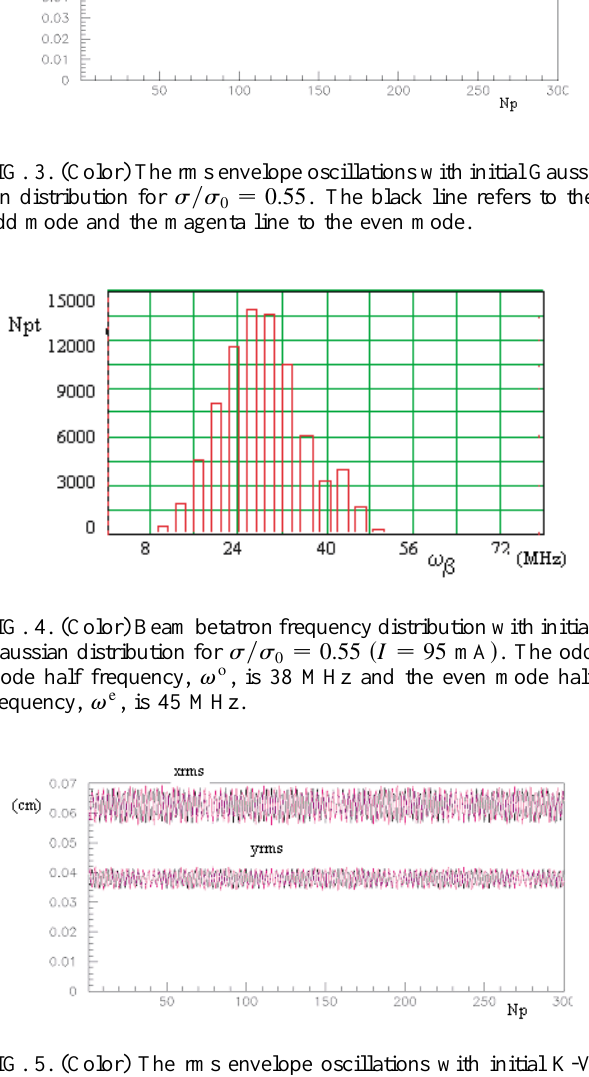
FIG. 5. (Color) The rms envelope oscillations with initial K-V distribution for s (cid:5) s 0 (cid:2) 0.83 . The black line refers to the odd mode and the magenta line to the even mode.